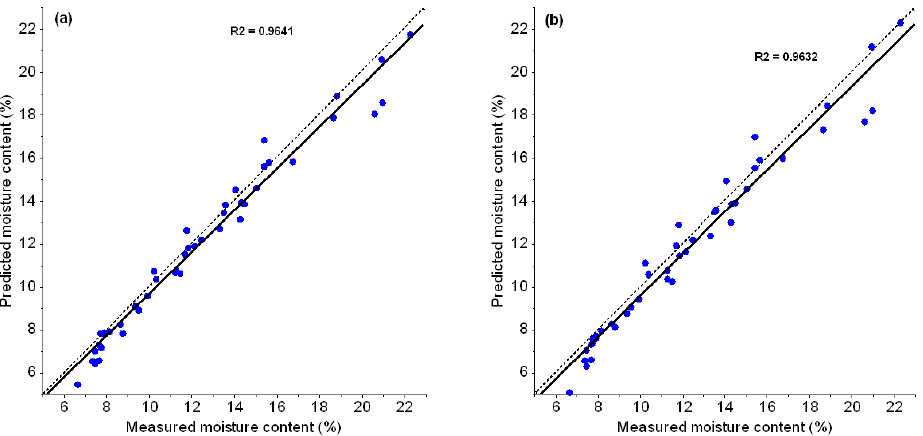
Figure 4. Predicted vs. measured moisture content of green coffee beans based on raw diffuse reflectance (log 1/R) near infrared spectra. ( a ) PLSR; ( b ) MLR.